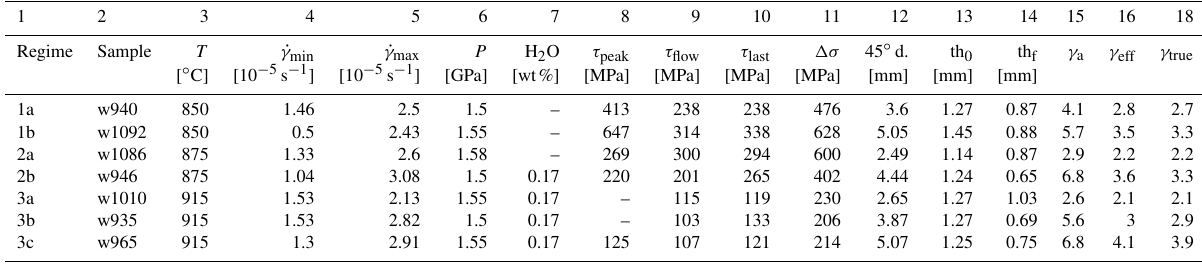
Table 1. Mechanical data for general shear experiments of Black Hills